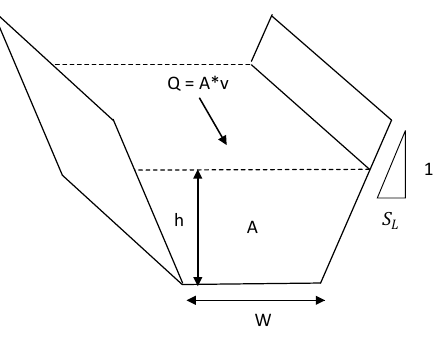
Figure 6: Side view of a trapezoidal flume the channel during transients when the boundary con- ditions are changed. Following the law of conservation of mass, the partial derivative of the discharge with respect to the length of the channel will be equal to the flow going into the channel minus the flow out of the channel. There is also a change in the fluid volume along the channel (i. e. the cross-sectional area of the flow) with respect to time. Both of these terms are of equal magnitude but different sign and combining them thus gives the continuity